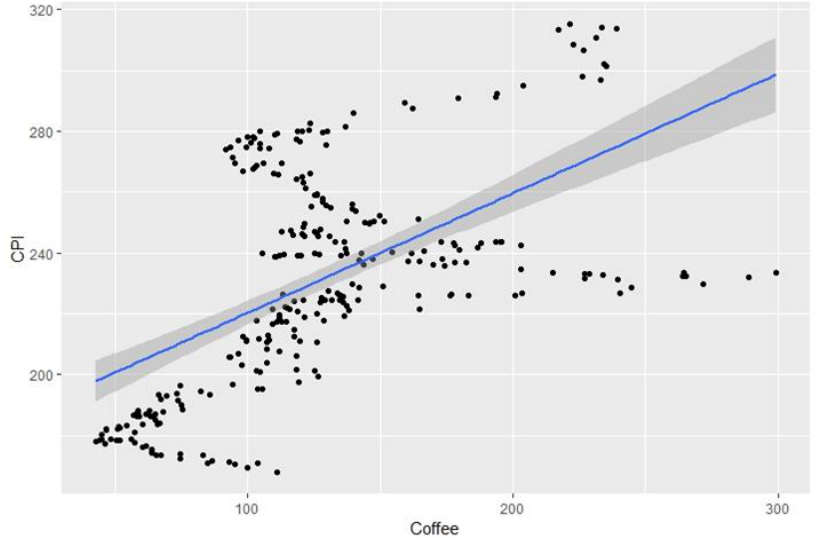
Figure 5. Linear regression based on Pearson correlation coefficient between CPI Los Angeles and Coffee. Own processing based on data from US Bureau of Labor Statistics and Yahoo Finance. This indicates a less close relationship between inflation and coffee price in Los Angeles, with a trend of moderate dependence.